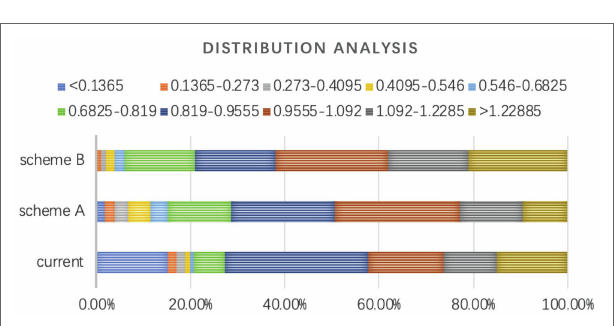
TABLE 3 | General comparison of the segment analysis (NACH, R = 1,200 m). Average 0.832521 0.910811 9.40